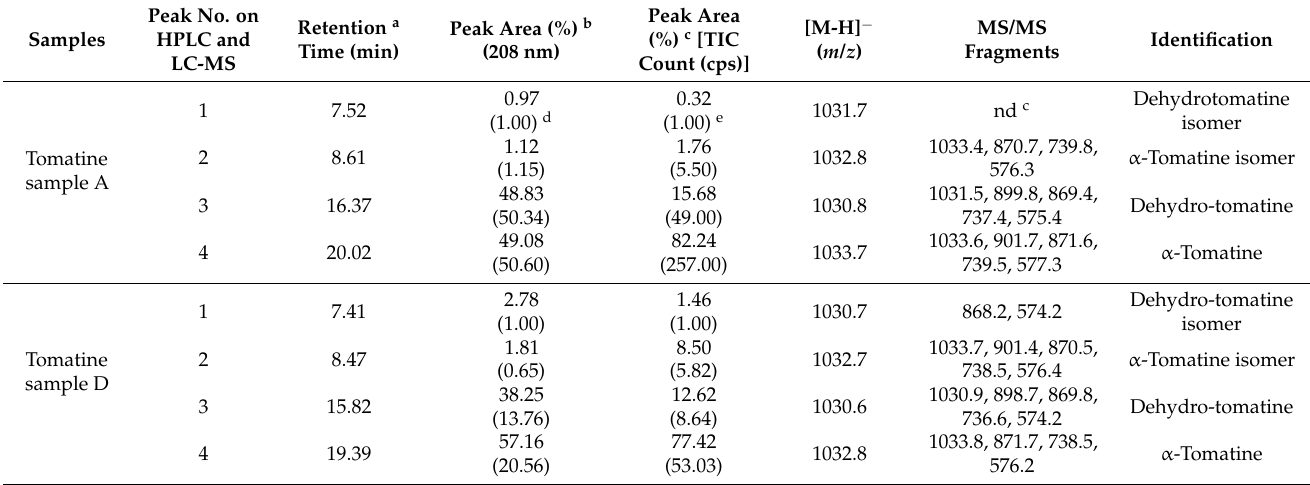
Table 2. Retention times, peak areas, MS, and MS/MS by LC-MS of tomatine samples A and D (column packing, 5 µ m particle size) a .